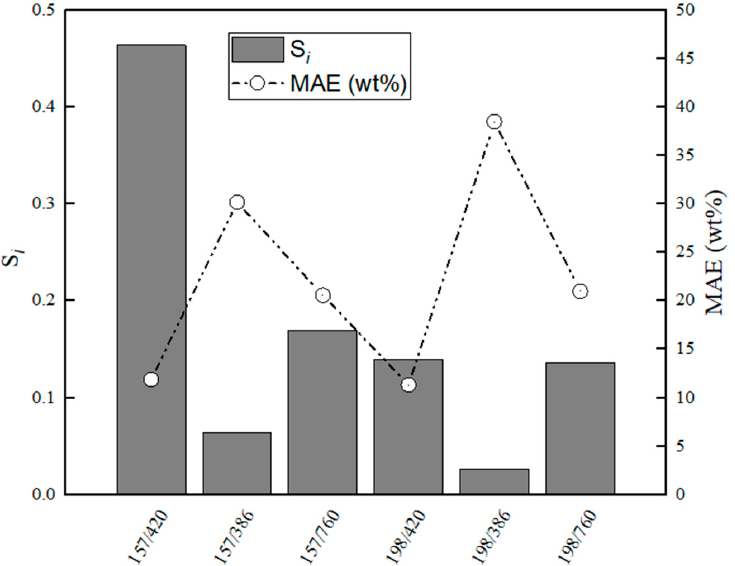
Figure 16. Evaluation of relative stabilities (Si) of the calibration variable candidates and mean absolute error values obtained for training and validation sets for CaS–Al 2 O 3 .